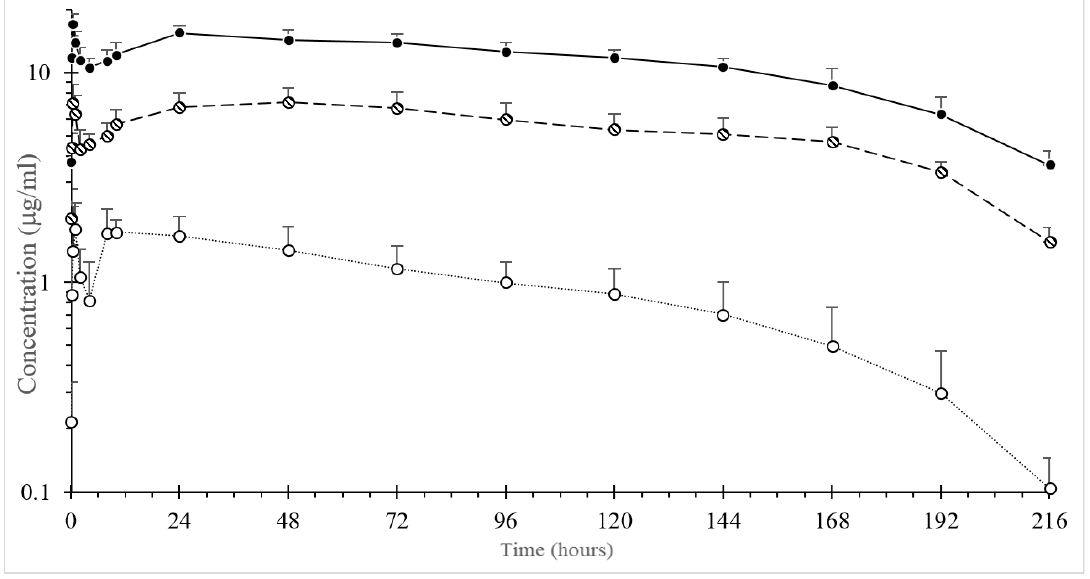
Figure 1. Semi-log average ( ± SD) plasma concentration versus time curve of long-acting formulation oxytetracycline after intramuscular administration at three di ff erent dosages of 5 mg / kg body weight (b.w.) (- -), 10 mg / kg b.w. (- θ -) and 20 mg / kg b.w. (- • -) in the freshwater crocodile, Crocodylus siamensis ( n = 5). Error bars indicate standard deviation.